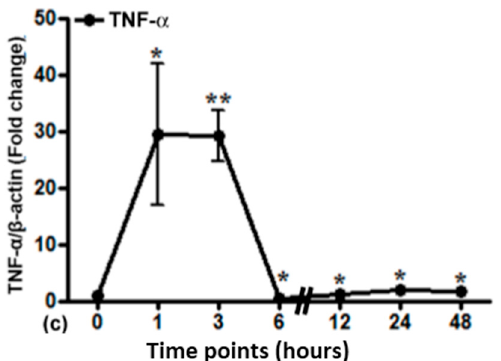
Figure 5. Relative mRNA expression of acute phase cytokines (IL-6 ( a ), IL-1 β ( b ) and TNF- α ( c )) in irradiated lung tissue. The results were normalized to β -actin as the housekeeping gene. Experimental errors are depicted as ±SEM (* p ≤ 0.05, ** p ≤ 0.005, n = 3).